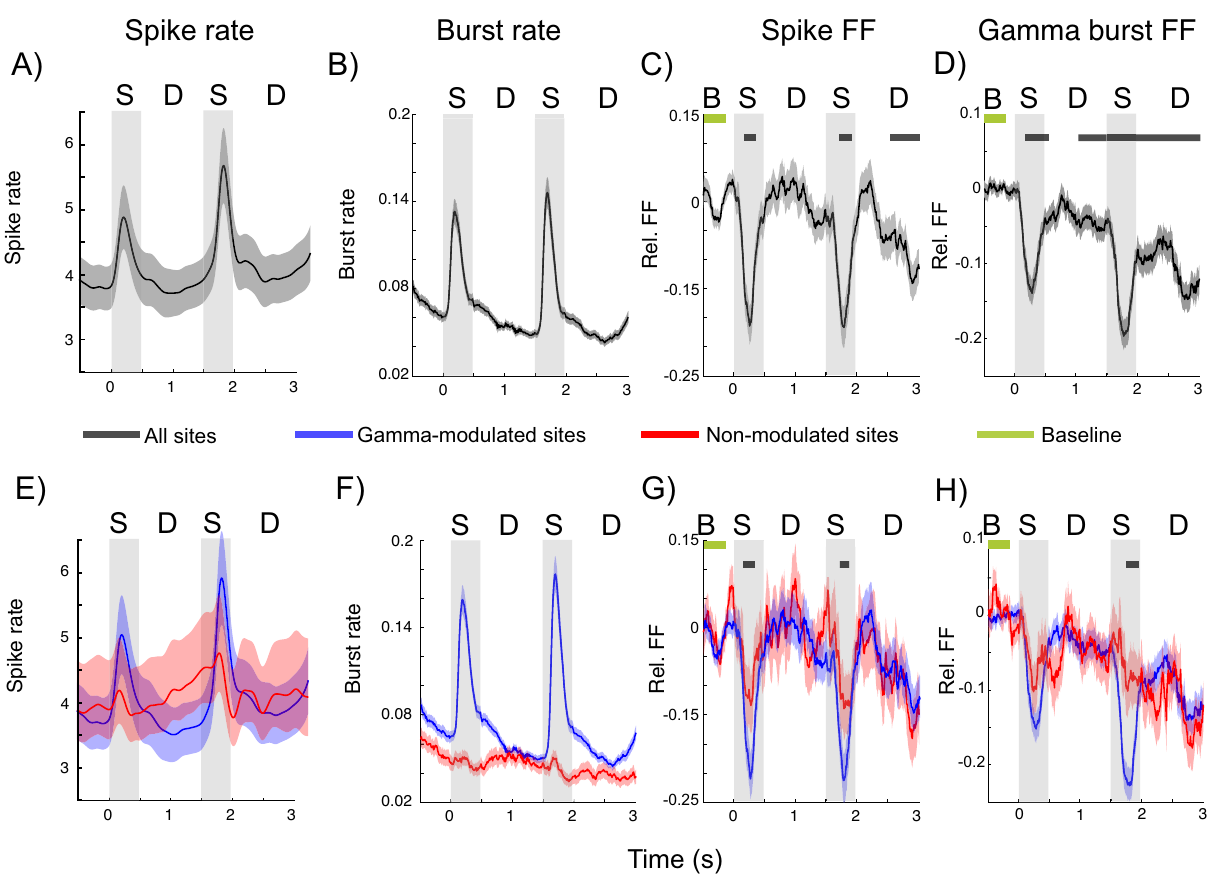
Figure 3. Spike and burst variability in Task 2. ( A ) Spike rates averaged across trials and all neurons (n = 283). Gray shaded regions indicate sample presentations (S; the first sample is presented at time = 0). The two delays are marked by ( D ). Error bars indicate standard error of the mean in all panels. ( B ) Gamma burst rates averaged across trials for all recording sites. ( C ) FF in spike times normalized by the pre-stimulus baseline (marked by “B”; from 500 to 100 ms prior to first sample onset) average. ( D ) FF in burst times normalized by the pre- stimulus (from 500 to 100 ms prior to first sample onset) average. ( E–H ) Same as ( A–D ) but separately for sites that increased (blue) gamma bursting at sample onset, and sites that did not (red).